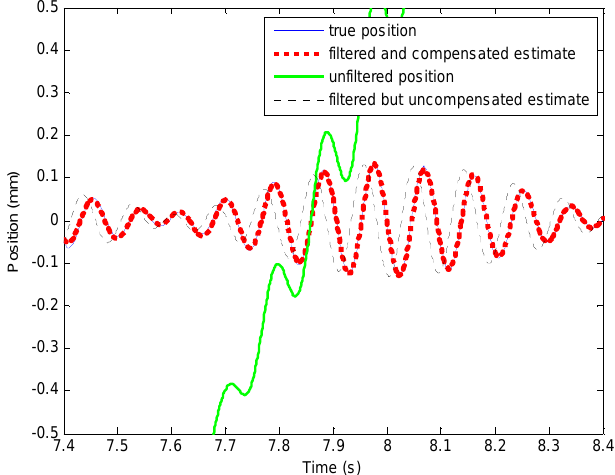
Figure 10. Plots showing effectiveness of the proposed method. The whole plot of the unfiltered position (shown in green line) can be seen in Figure 9.